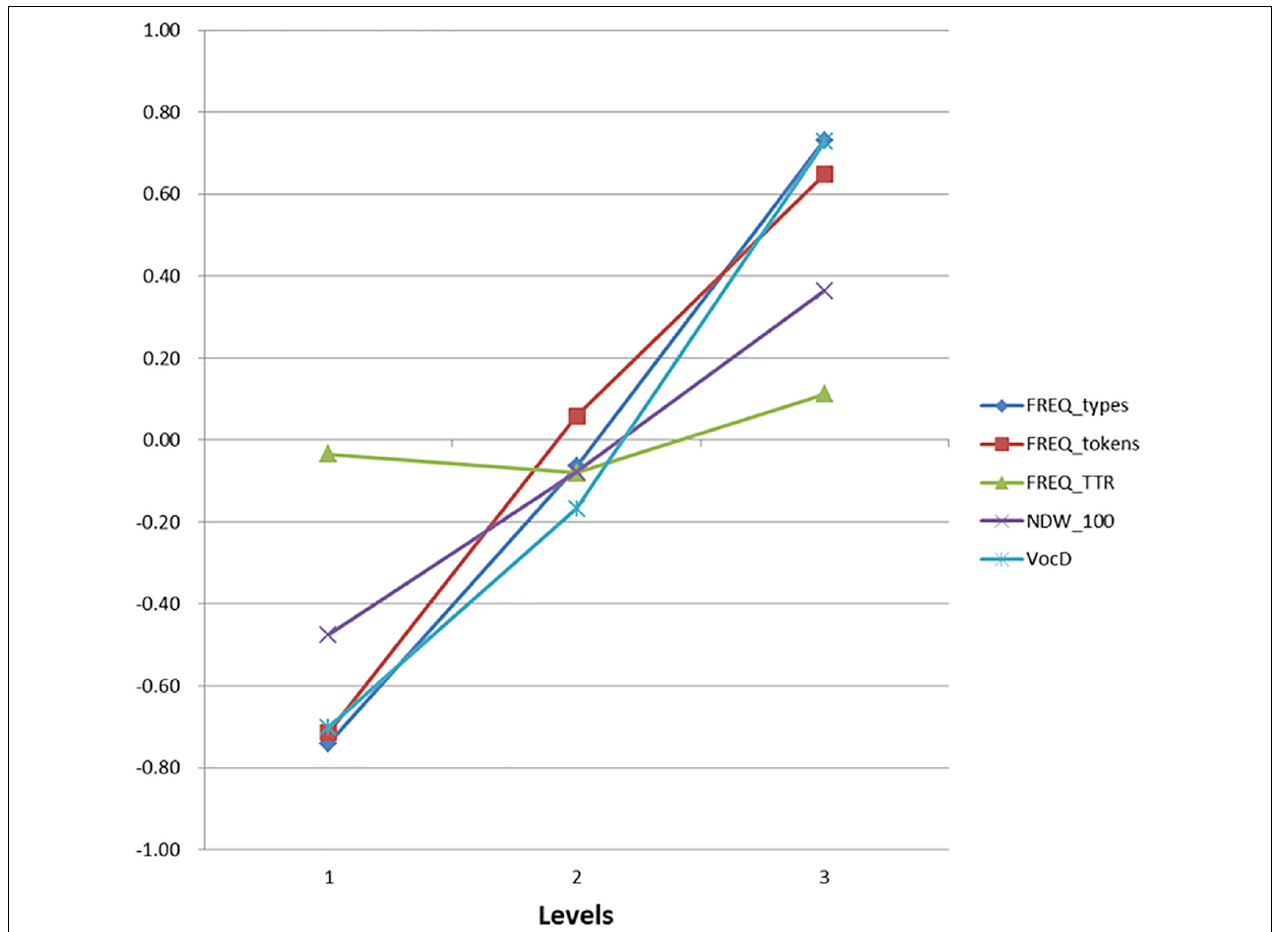
FIGURE 2 | Means of the Z -score of vocabulary indicators among the three levels. FREQ_types, total number of different words; FREQ tokens, total number of words; FREQ_TTR, type/token ratio; NDW_ 100, number of different words in the first 100 words; VocD, vocabulary diversity